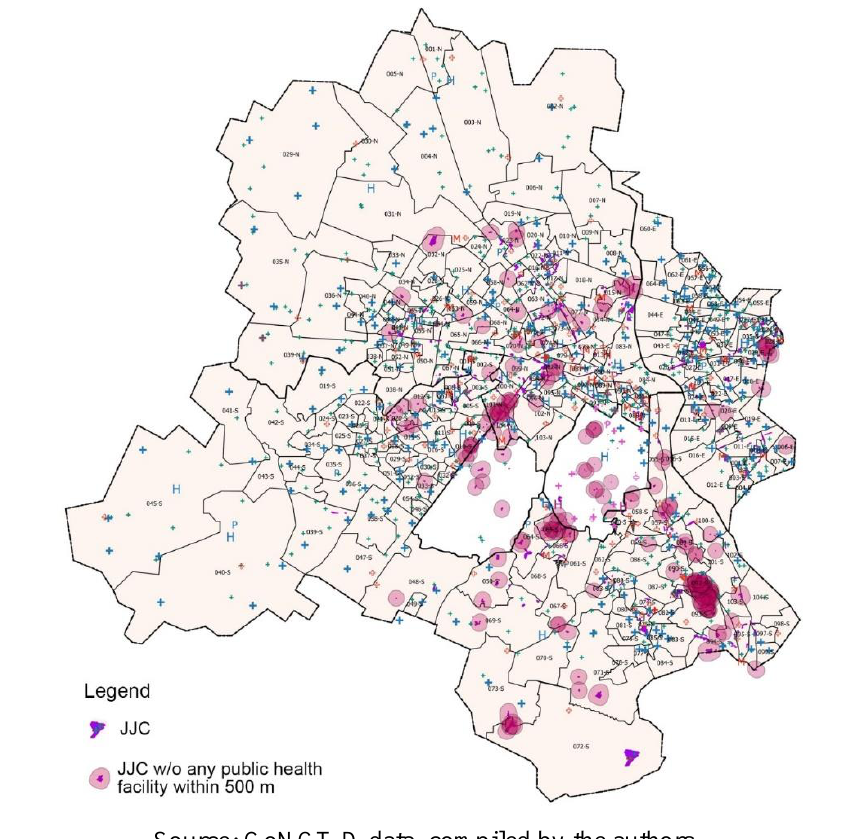
Figure 14: Slums (JJC) without any public health services within 500